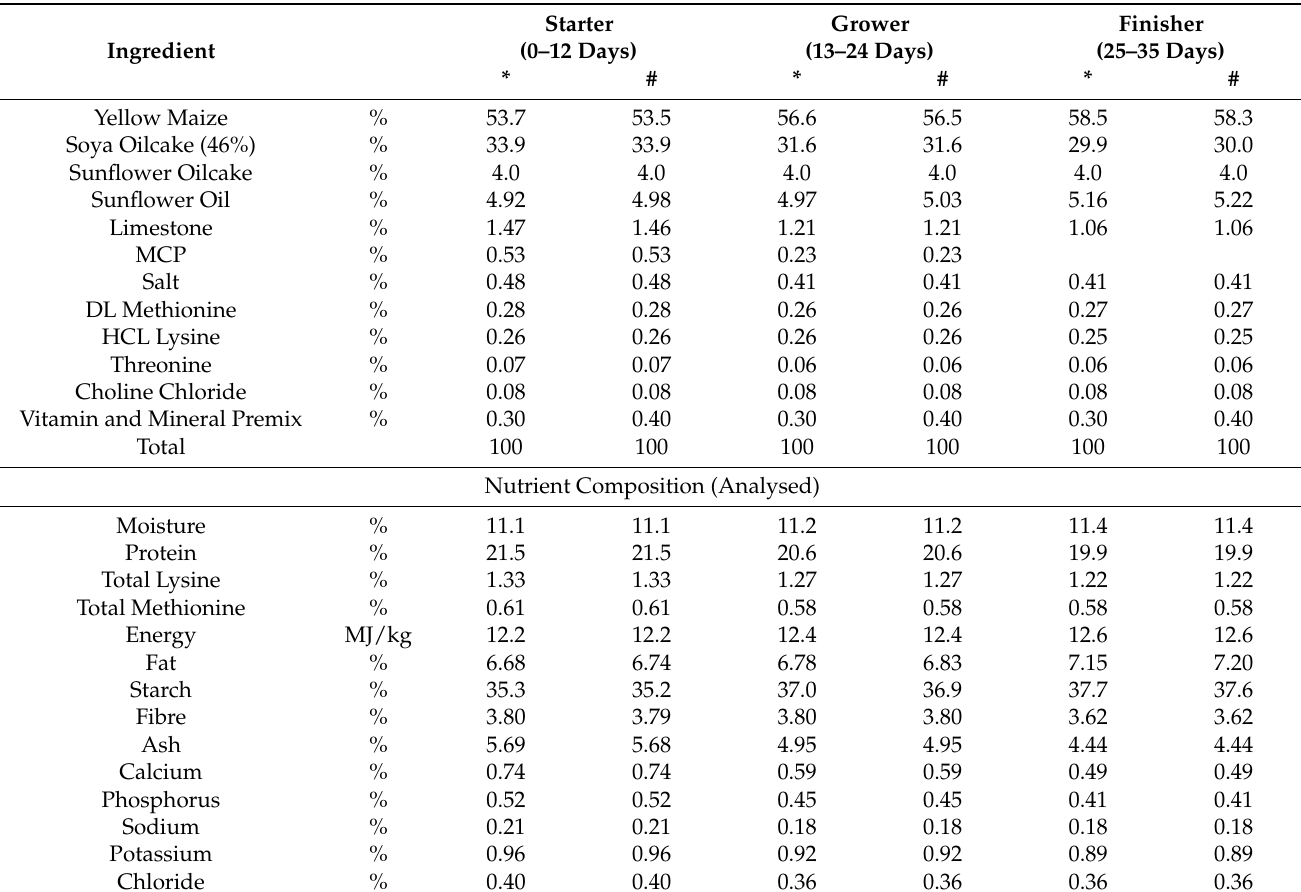
Table 1. The composition and calculated nutrient content of broiler rations (as-fed) in the starter